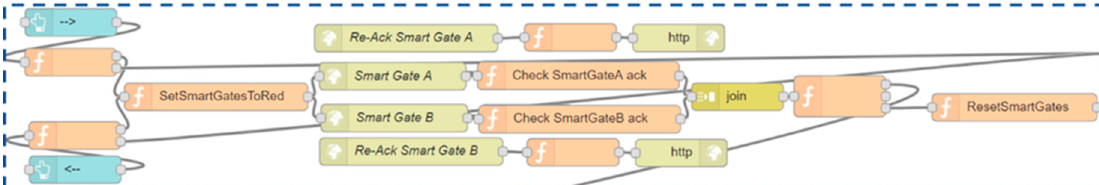
Figure 8. Complete flow of Node-RED that allows to realize the “Smart Gate Change” protocol.